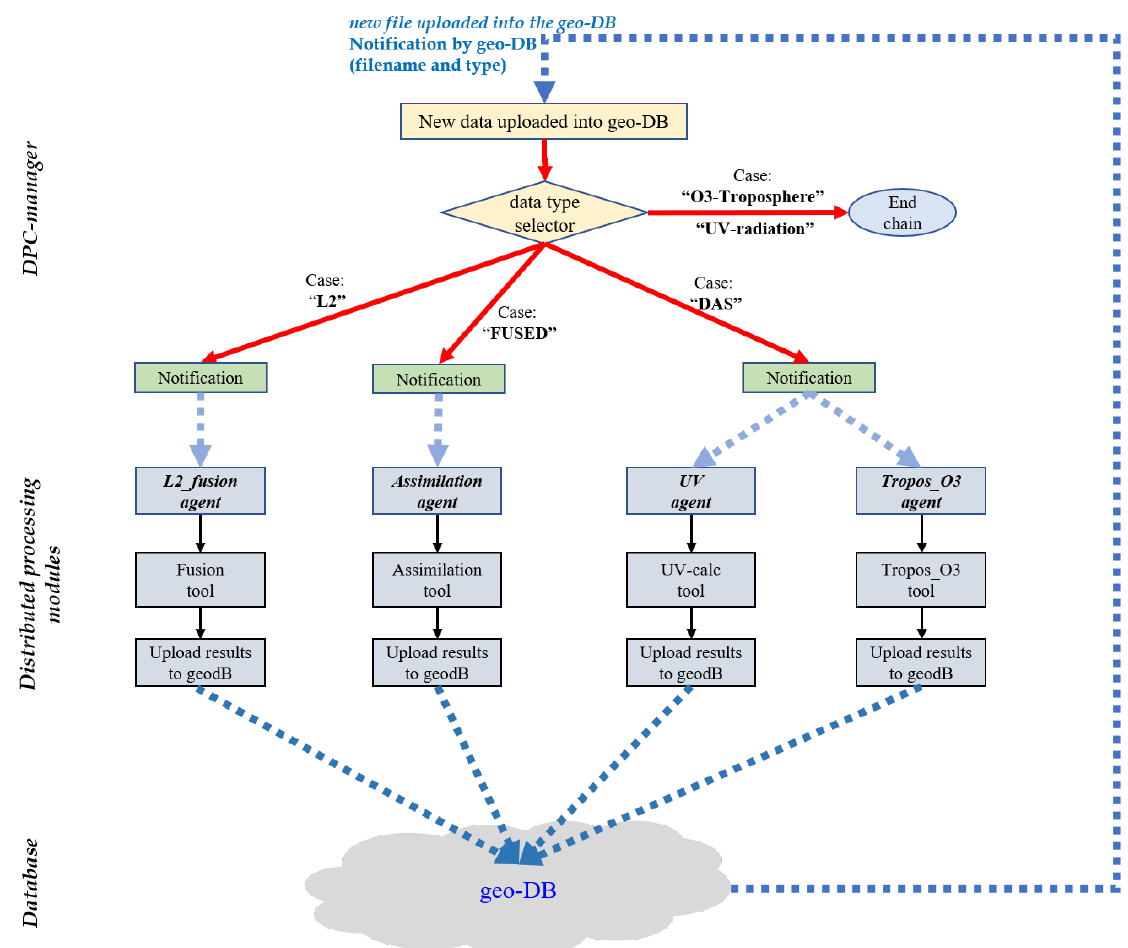
Figure 11. High level flow chart of the DPC-manager supervising